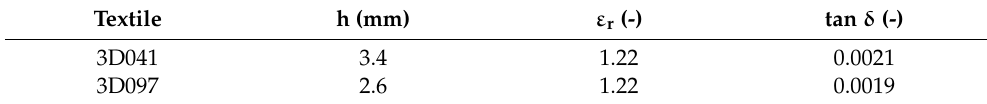
Table 1. Parameters of selected 3D